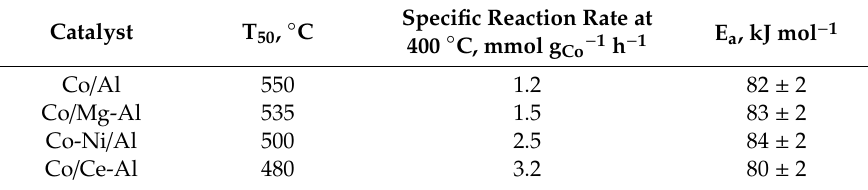
Figure 10. Light o ff curves of the supported cobalt catalysts. Figure 10. Light off curves of the supported cobalt catalysts. Table 4. Kinetic results of the supported cobalt Table 4. Kinetic results of the supported cobalt catalysts.